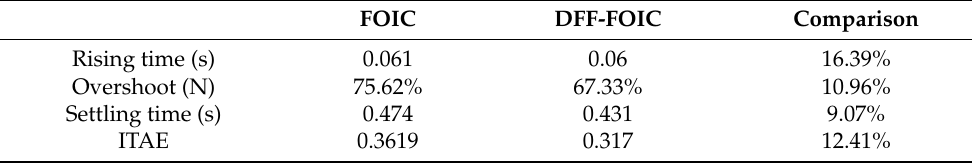
Figure 19. Force step response curve comparison for FOIC and DFF-FOIC. Table 10. Force step response performance comparison for FOIC and